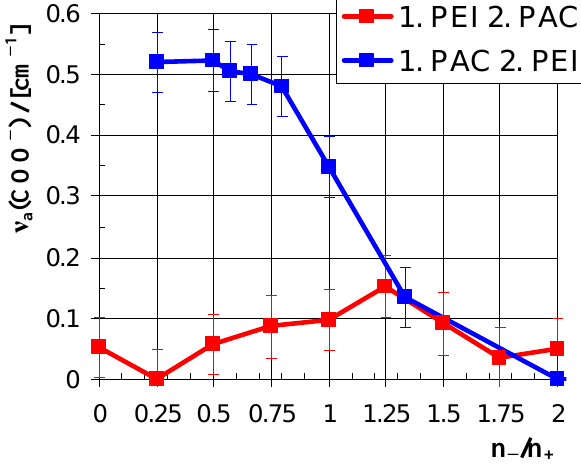
Figure 14. Course of the  (COO − ) band integrals diagnostic for the deposition of a PEI/PAC complex layers upon dosing either PAC to PEI solution (1. PEI 2. PAC) or PEI to PAC solution (1. PAC. 2. PEI) in direct contact with the cellulose model film dependent on mixing ratio n /n for c =0.001 − + PEL